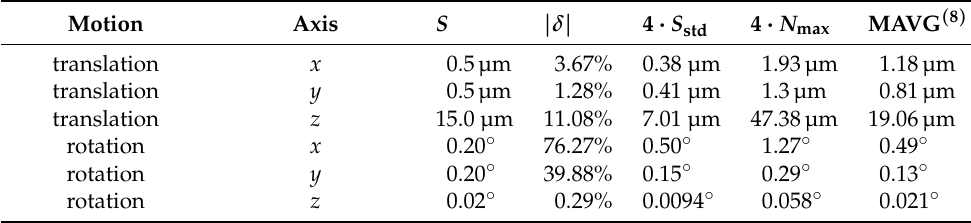
δ , the standard deviation of the step sizes | | N max . ·